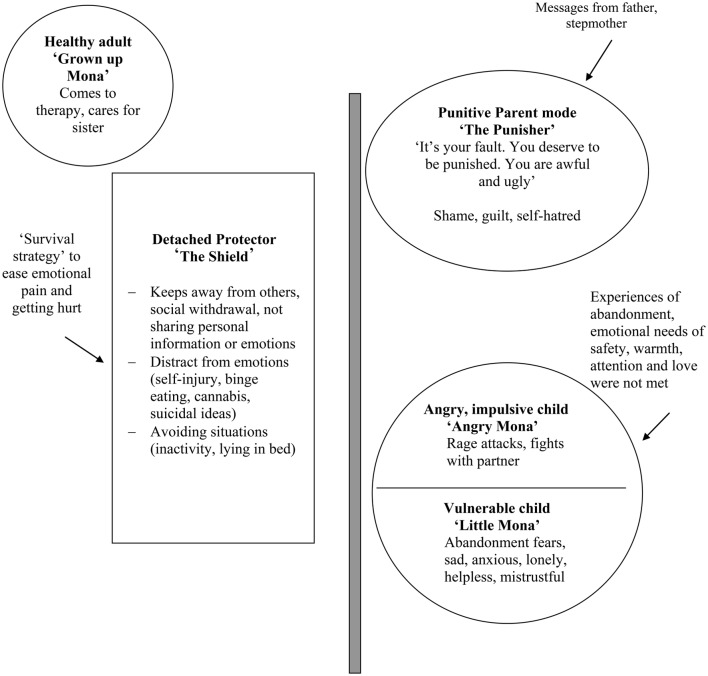
Mona's mode model.